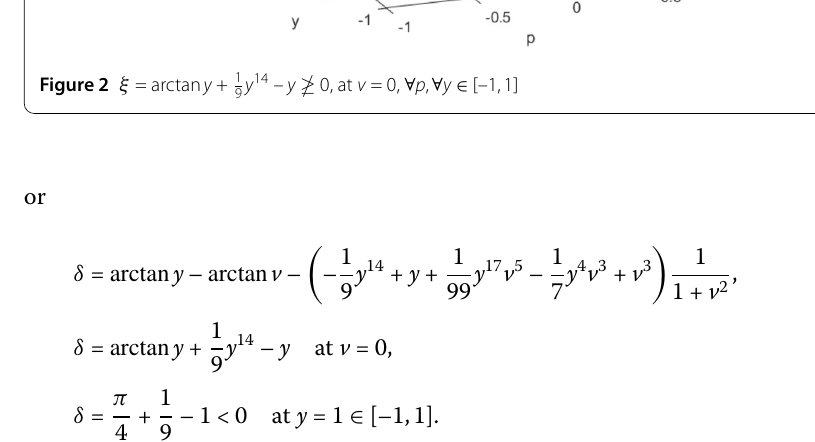
Figure 2 ξ = arctan y + 1